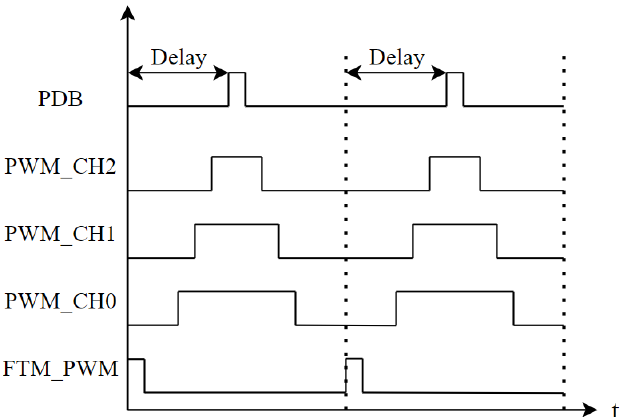
Figure 21. PWM and PDB trigger timing.